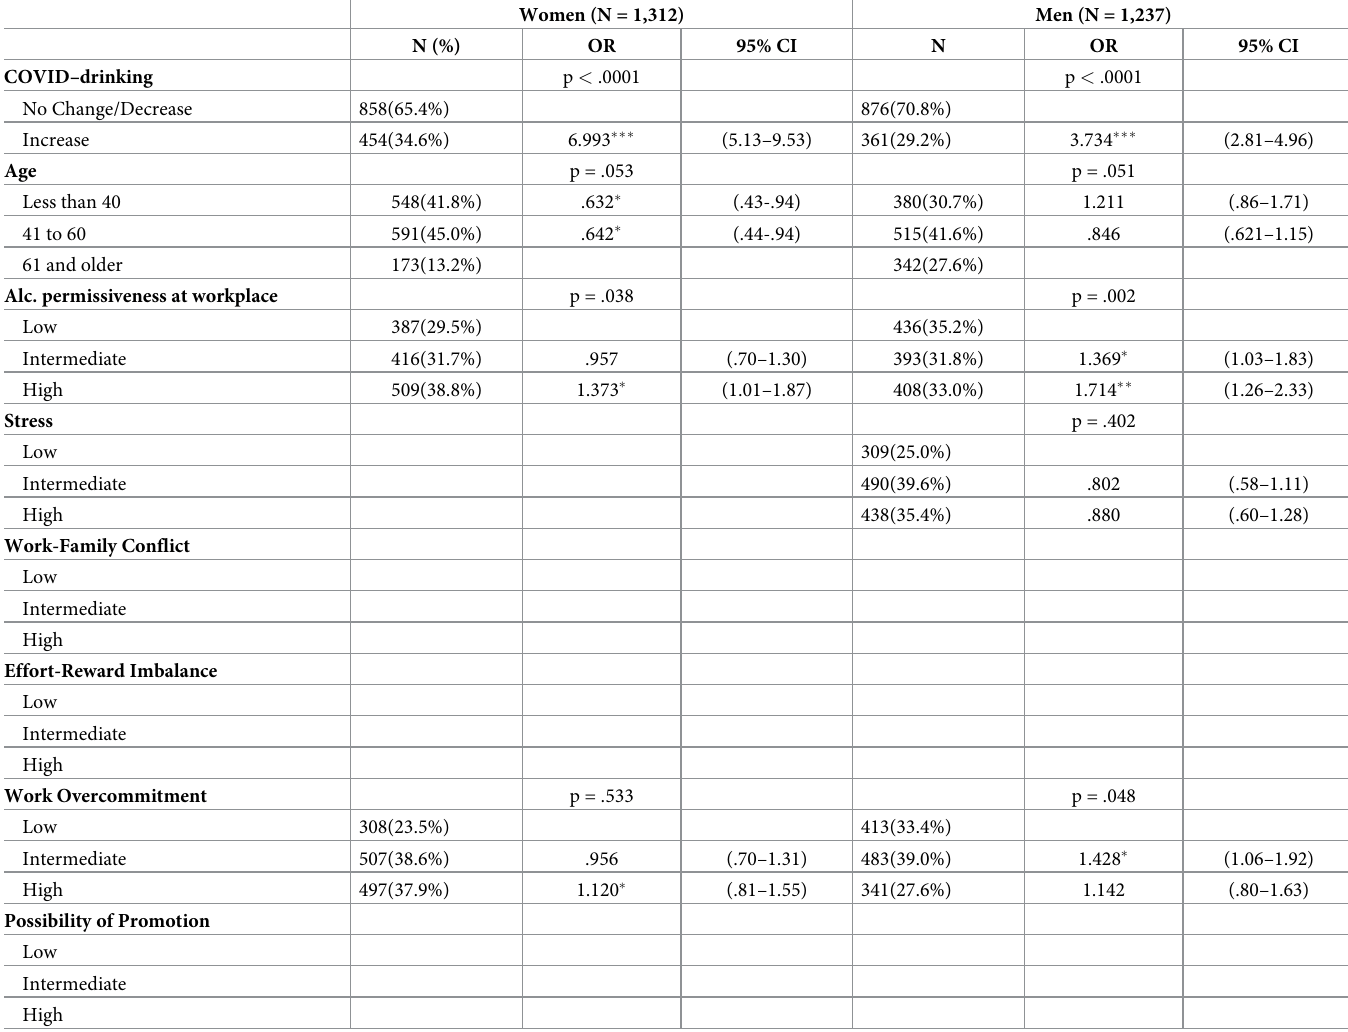
Table 5. Work-related predictors of risky